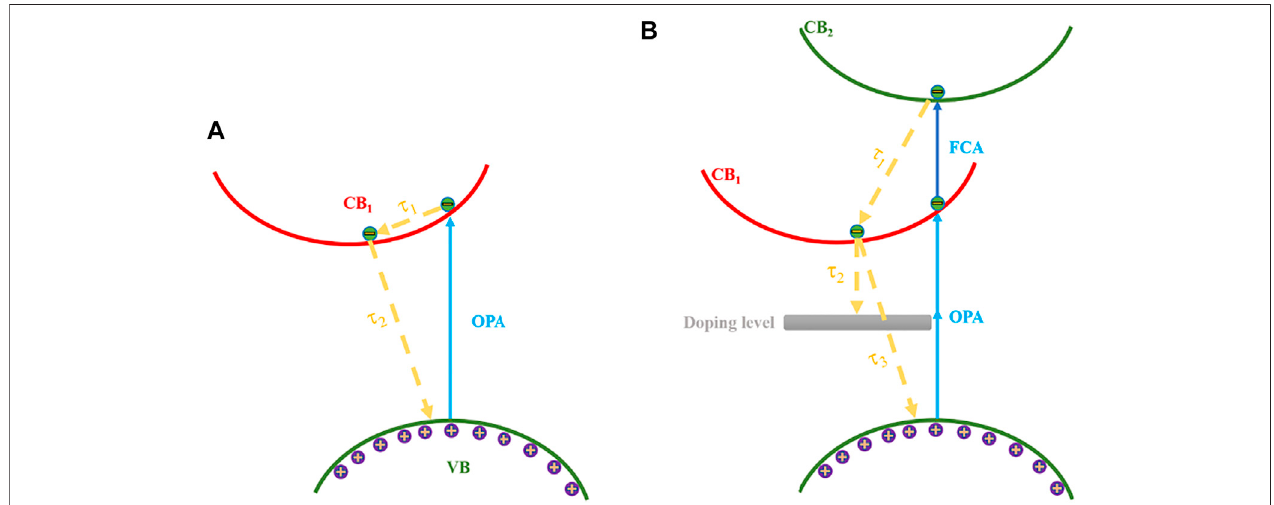
FIGURE 10 | (A) The process of pure Sb 2 Se 3 nano fi lm carrier relaxation time, OPA, and band. (B) The illustration of Co-doped Sb 2 Se 3 nano fi lm carrier relaxation time, OPA, and